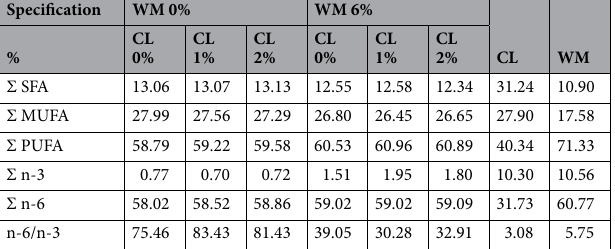
Table 1. Fatty acids profile in diet’s structure and nutritional supplements. WM Walnut meal, CL Cranberry leaves, SFA Saturated fatty acids, MUFA Monounsaturated fatty acids, PUFA Polyunsaturated fatty